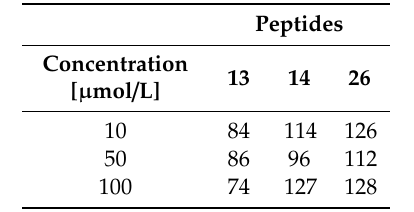
Table 4. DNA biosynthesis (% of Control ± 2).